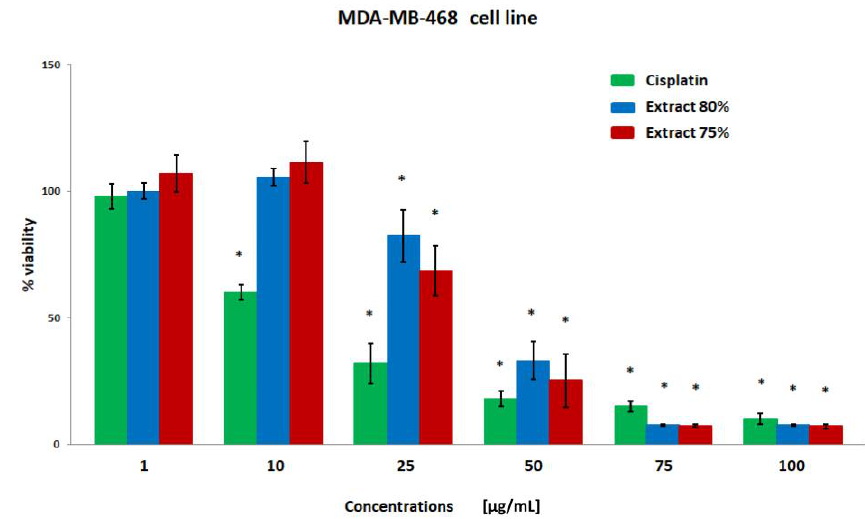
Figure 2. The viability of the MDA-MB-468 cell line (%) after 24 h incubation with various concen- trations of cisplatin, extract 80% and extract 75% measured with MTT test. Significant values (*) compared with Cisplatin with p < 0.05 (one-way ANOVA with Tukey’s post hoc test).